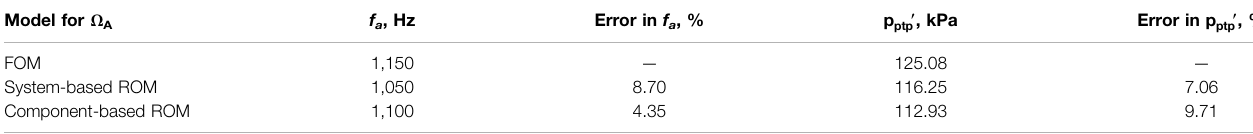
TABLE 1 | Comparisons of the dominant acoustic frequency ( f a ) and the peak-to-peak pressure amplitudes ( p ptp ′ ) with different models (component-based ROM vs. system-based ROM vs. FOM) used for the upstream injector element for the single-injector combustor, corresponding to the results in Figure 6A . Model for Ω A